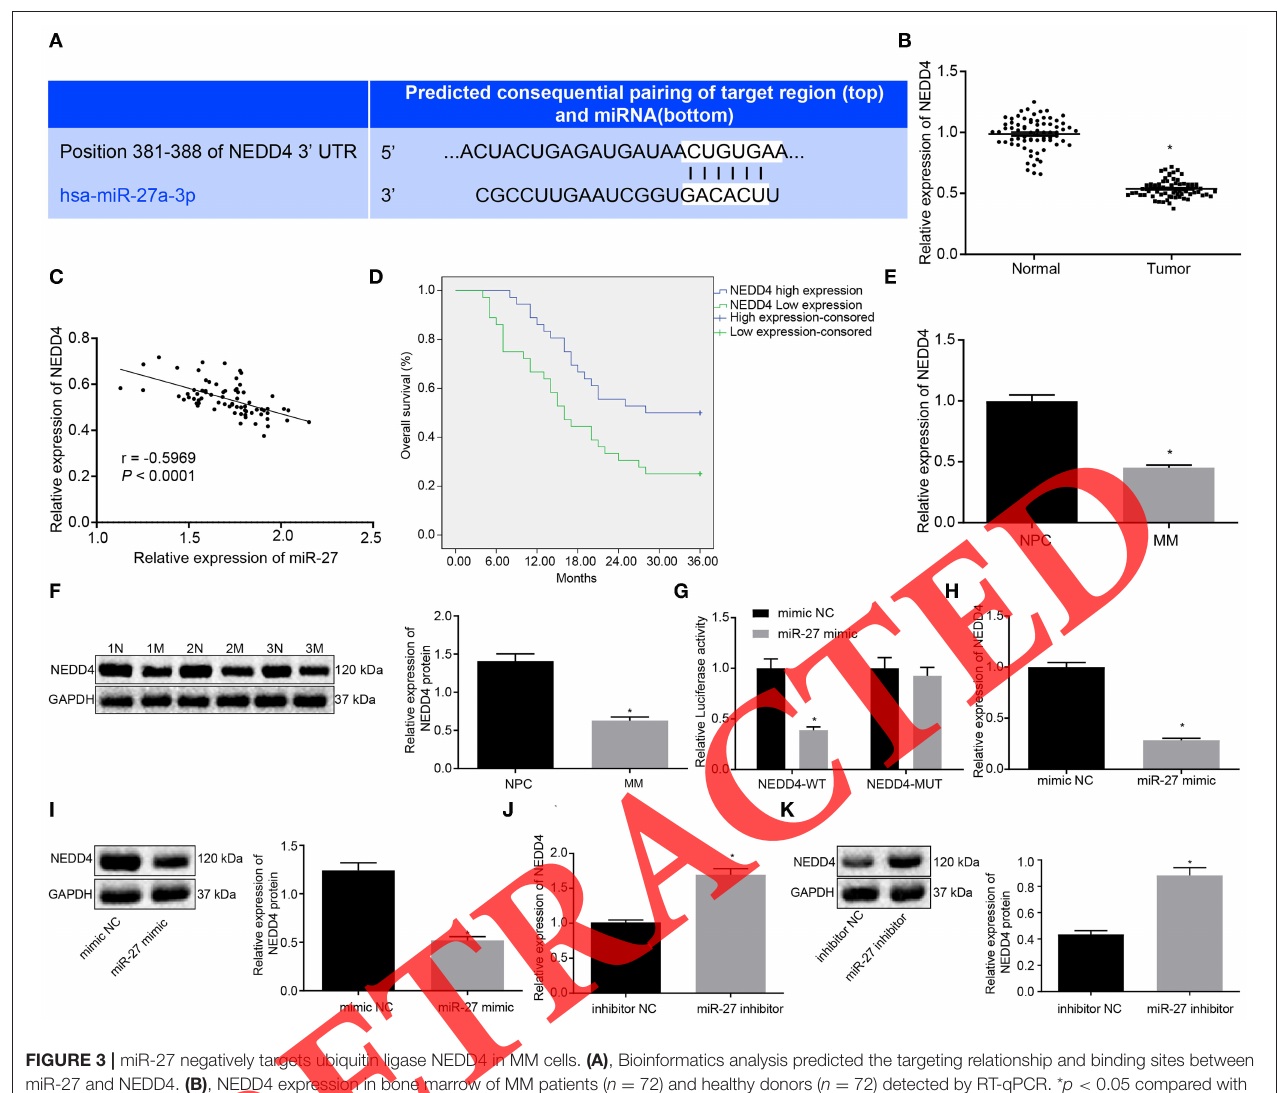
FIGURE 3 | miR-27 negatively targets ubiquitin ligase NEDD4 in MM cells. (A) , Bioinformatics analysis predicted the targeting relationship and binding sites between miR-27 and NEDD4. (B) , NEDD4 expression in bone marrow of MM patients ( n = 72) and healthy donors ( n = 72) detected by RT-qPCR. * p < 0.05 compared with bone marrow of healthy donors. (C) , Correlation analysis between miR-27 and NEDD4 expression in bone marrow of MM patients ( n = 72) and healthy donors ( n = 72). (D) , Correlation of NEDD4 expression with OS of patients analyzed by Kaplan–Meier. (E) , The expression of NEDD4 mRNA in bone marrow plasma cells from MM patients and NPCs detected by RT-qPCR. (F) , The expression of NEDD4 protein in bone marrow plasma cells from MM patients and NPCs detected by western blot analysis. N, NPC cell; M, MM cell. * p < 0.05 compared with NPCs. (G) , Luciferase report to show the targeting relationship between miR-27 and NEDD4 mRNA. * p < 0.05 compared with mimic NC treatment. (H) , Expression of NEDD4 mRNA in H929 cells treated with mimic NC or miR-27 mimic detected by RT-qPCR. (I) , Expression of NEDD4 protein in H929 cells treated with mimic NC or miR-27 mimic detected by western blot analysis. * p < 0.05 compared with H929 cells treated with mimic NC. (J) , Expression of NEDD4 mRNA in H929 cells treated with inhibitor NC or miR-27 inhibitor detected by RT-qPCR. (K) , Expression of NEDD4 protein in H929 cells treated with inhibitor NC or miR-27 inhibitor detected by western blot analysis. * p < 0.05 compared with H929 cells treated with inhibitor NC. The data were measurement data and expressed as mean ± standard deviation. Unpaired t -test was used for comparison between two groups. Pearson correlation analysis was used to analyze the relationship between miR-27 and NEDD4 expression. The Kaplan–Meier method was used to analyze the correlation between NEDD4 expression and OS in patients. The cell experiment was repeated three